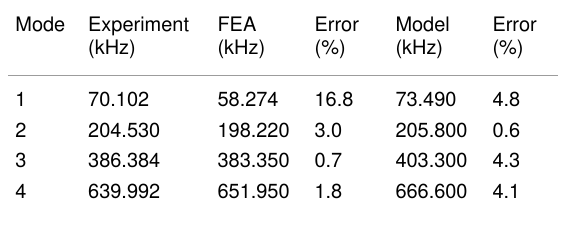
Table 1: Modeled and observed dynamic behavior for a free AFM can-